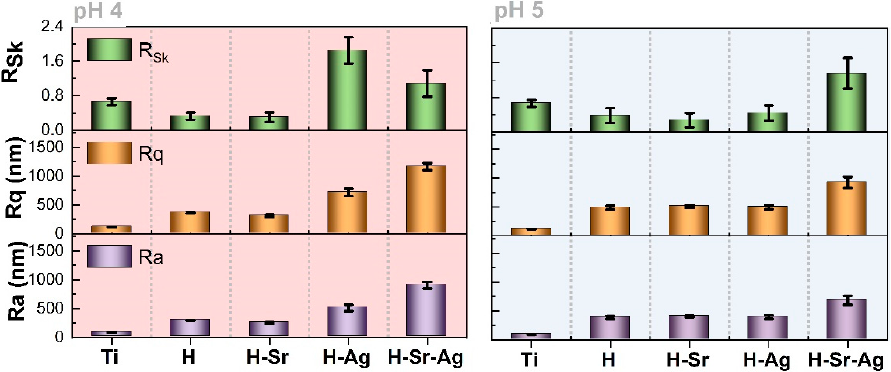
Figure 7. Roughness parameters of the HAp-based coatings and substrate at pH 4 ( left ) and pH 5 ( right ).